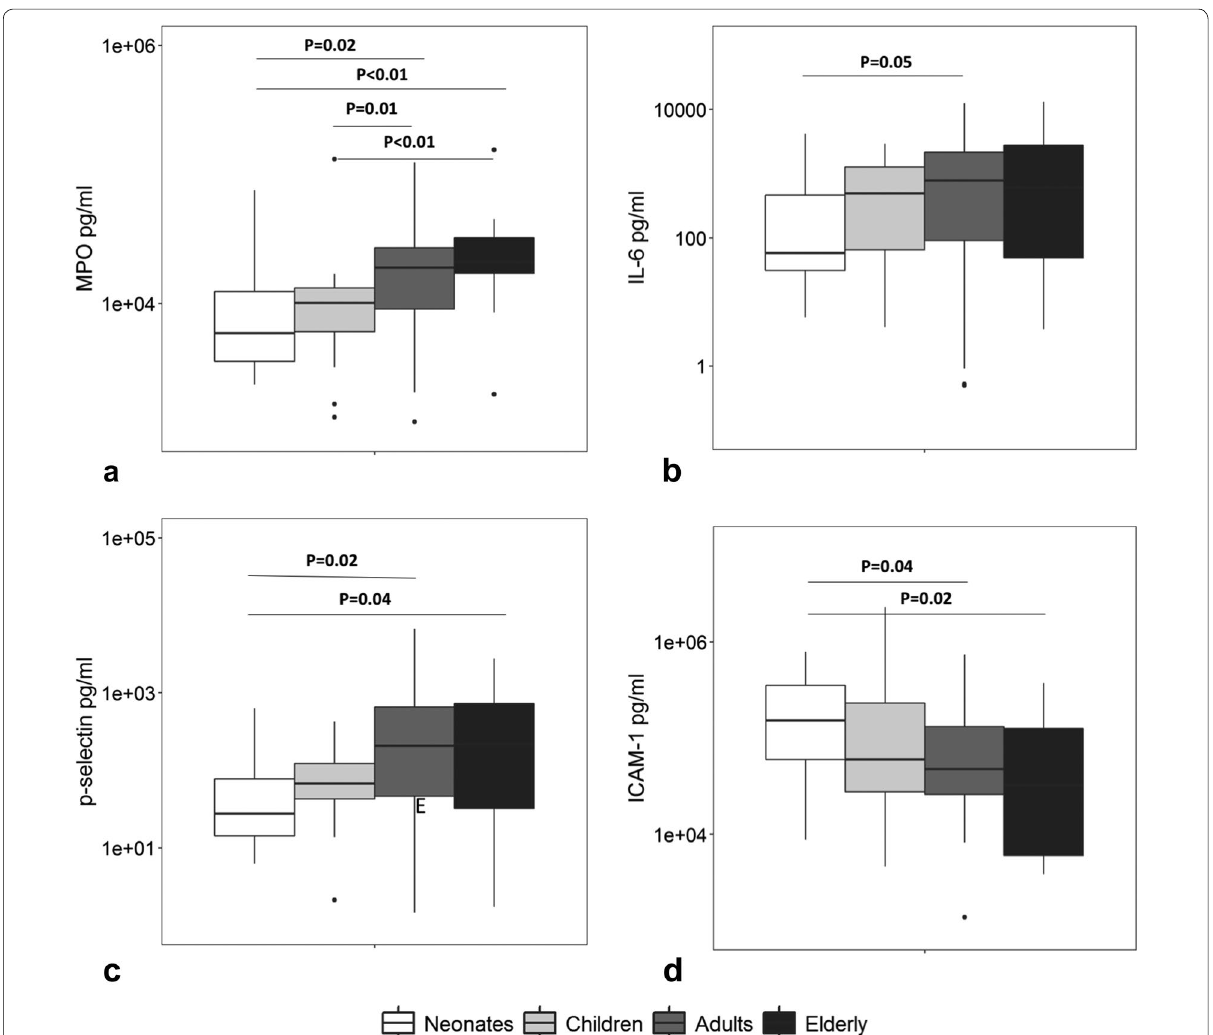
Fig. 2 Markers of inflammation, endothelial activation and epithelial activation in bronchoalveolar lavage fluid of ARDS patients. a Myeloperoxidase (MPO), b interleukin (IL)‑6, c p‑selectin, d intercellular adhesion molecule (ICAM)‑1 levels in bronchoalveolar lavage (BAL) fluid of ARDS patients stratified by four age groups. Horizontal bars represent the median. Group differences were tested with a Dunn’s test with Bonferroni correction for multiple comparisons. A p value less than 0.05 was considered statistical